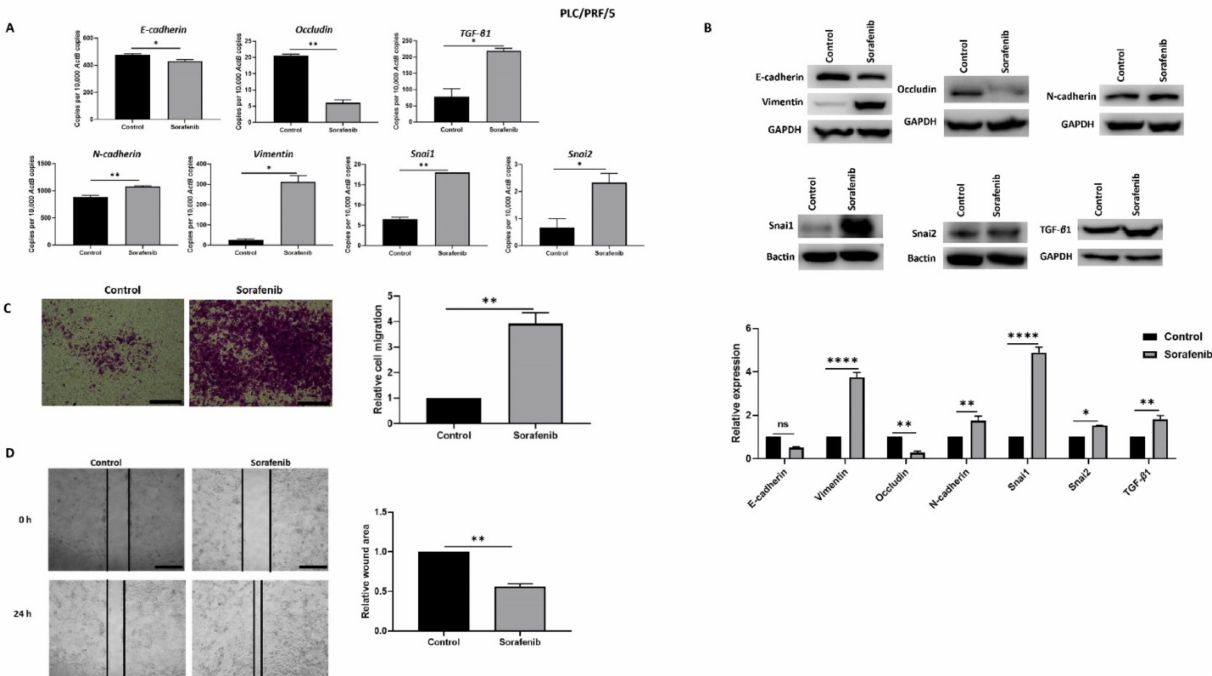
Figure 1. PLC/PRF/5 cells undergo EMT after Sorafenib treatment. ( A ) qRT-PCR revealed decrease in E-cadherin and Occludin and increase in TGF- β 1, N-cadherin, Vimentin, Snai1, and Snai2 after treatment with 6.965 µ M Sorafenib for 72 h. ( B ) Western blot analysis showed downregulation of E-cadherin and Occludin and upregulation of Vimentin, N-cadherin, Snai1, Snai2, and TGF- β 1 upon treatment with Sorafenib. GAPDH and Bactin were used as loading controls. ( C ) The migratory capability of PLC/PRF/5 cells was enhanced upon treatment with Sorafenib as revealed by the transwell migration assay (scale bar = 500 µ m). The number of motile cells was directly proportional to the absorbance of Crystal Violet staining. ( D ) Wound healing assay (scale bar = 500 µ m) showed higher migratory capacity of Sorafenib treated PLC/PRF/5 cells. Quantitative analysis of the wound area after 24 h Sorafenib treatment relative to the starting wound area at 0 h ( n = 3, * p < 0.05, ** p < 0.01, **** p <